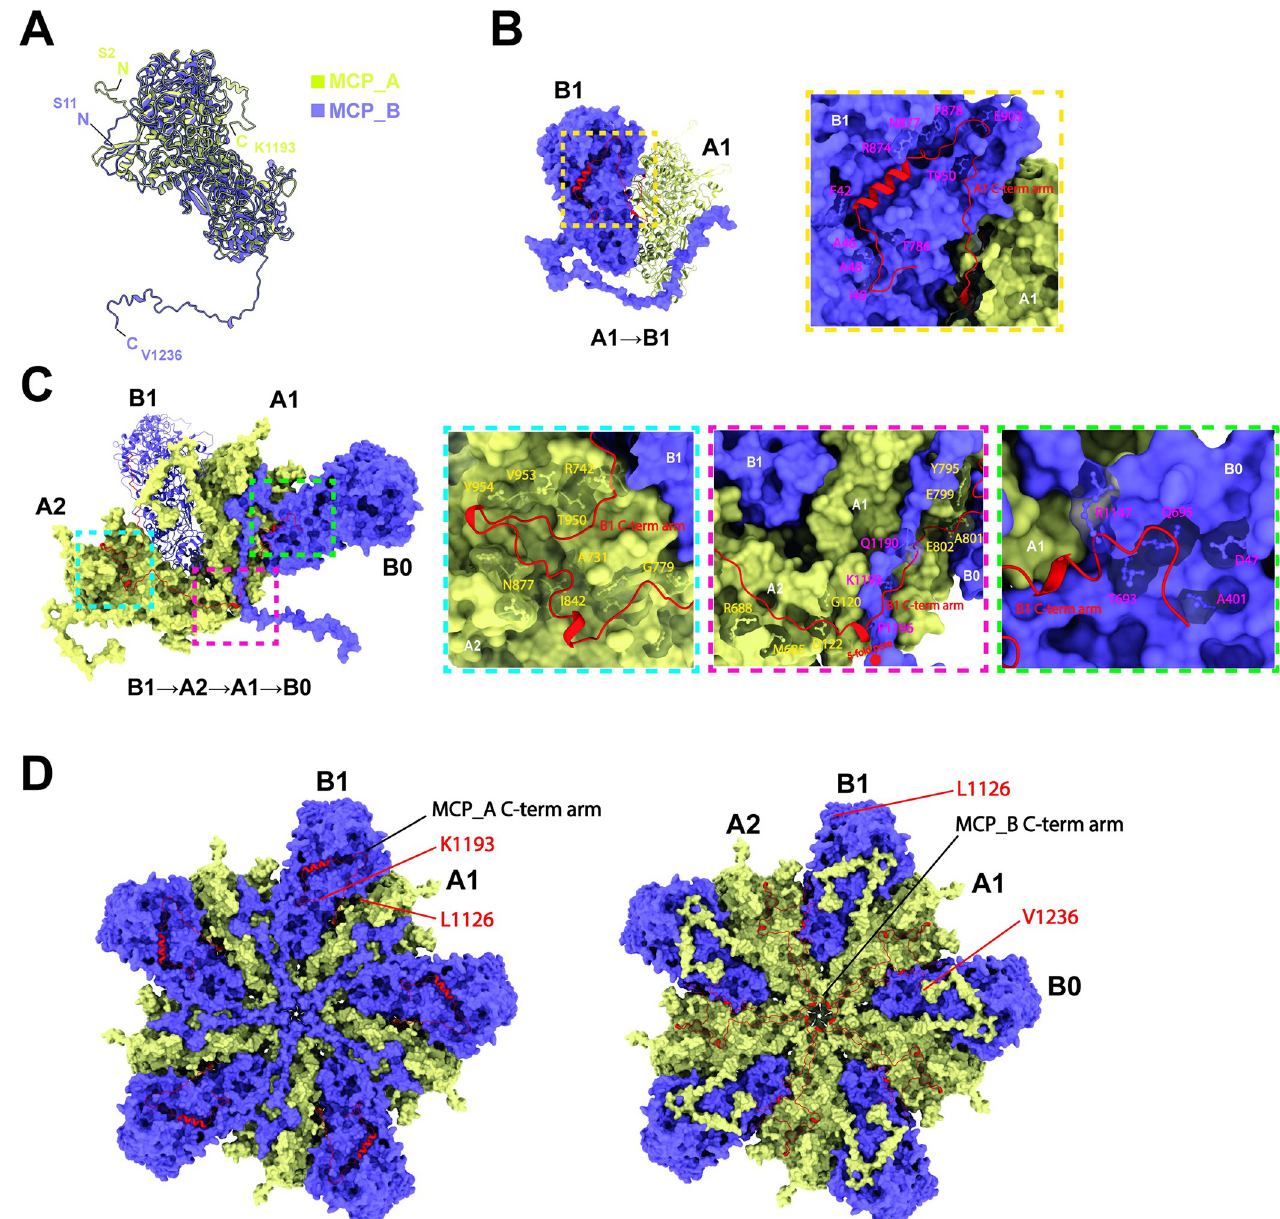
Fig 2. Extra-long C-terminal arms and the interlocking interface. A) Superimposition of the MCP_A subunit (yellow) and B subunit (purple). B) Interactions of the C-terminal arm of MCP_A subunit (A1) with one adjacent MCP_B subunit (B1). Close-up view of the interactions between the C-terminal arm of A1 (Leu1126–Lys1193) and the amino acid residues in B1 (dotted yellow box). C) Interactions of the C-terminal arm of MCP_B subunit (B1) with two adjacent MCP_A subunits (A1, A2) and another MCP_B subunit (B0). Close-up view of the interactions between the C-terminal arm of B1 (Leu1126–Val1236) and the amino acid residues in the A2 (dotted light blue box), A1 (dotted red box), and B0 (dotted green box). D) Overall representation of C-terminal arms within a 5-fold complex made up with ten subunits. Both panels show the view inside the capsid. B, C, D) MCP_A and MCP_B subunits are colored yellow and purple, respectively, and are shown in surface representation. The C-terminal arms are colored by red and shown in cartoon representation. The interacting residues are found by contact distance restrictions of 3.8 Å in UCSF Chimera X. The interacting amino acid residues of the MCP_A and MCP_B subunits are labeled in yellow and magenta and represented in ball-and-stick